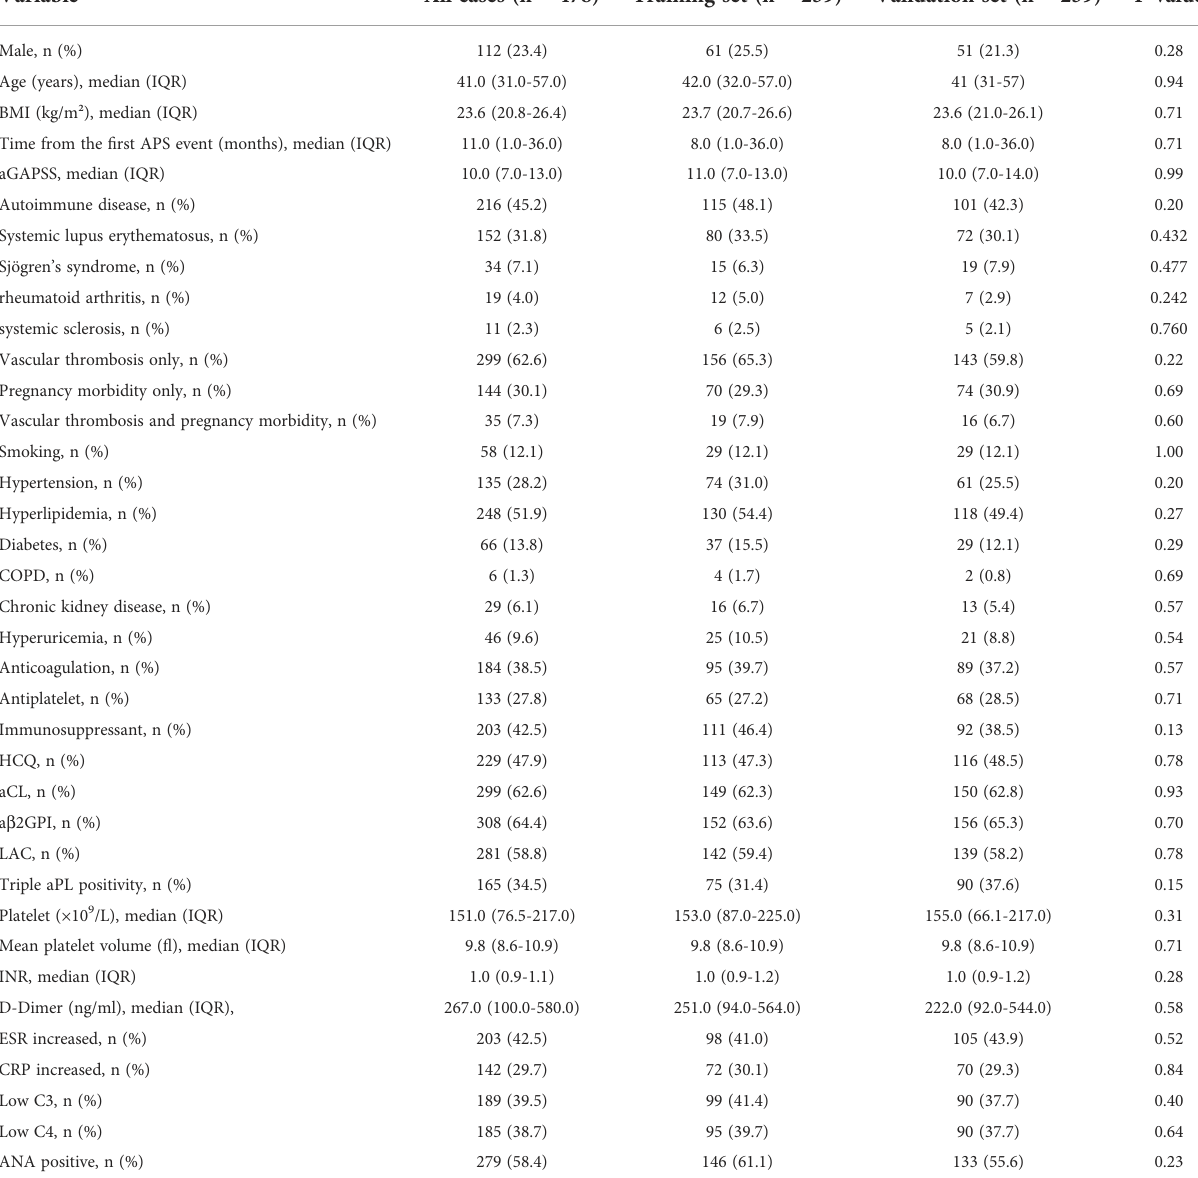
TABLE 1 Demographic and clinical variables of APS patients at